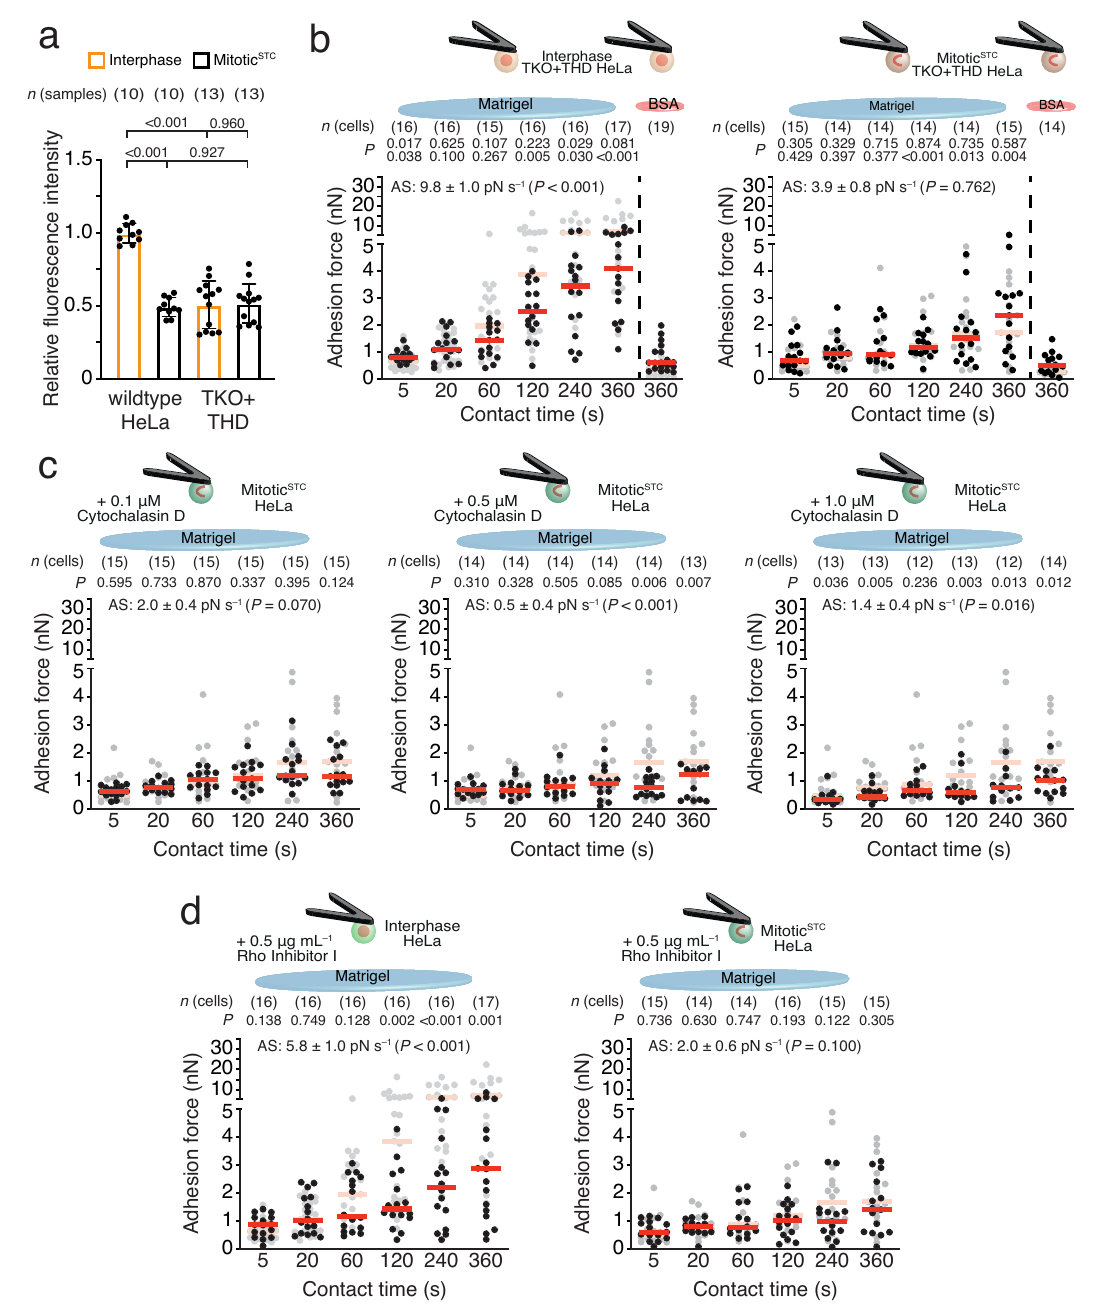
Fig. 6 | Mitotic cells do not engage integrins to the contractile actomyosin. a Fluorescence intensity of wildtype (Fig. 2b) or talin1-head domain expressing (TKO+THD) HeLa cells labeled for extended β 1 integrins (clone 9EG7). Dots represent median fl uorescence intensities of 20,000 cells normalized to the mean median fl uorescenceintensityofuntreatedinterphaseHeLacells,barsthemeanof allnormalizedmedians,and errorbarstheirSEM. n (samples)indicatesthenumber of biological independent samplestested. b Adhesionforcesofinterphase(left) or mitotic STC (right)TKO+THDHeLacellstoMatrigelorBSAaftergivencontacttimes. Dotsrepresentadhesionforcesofsinglecells,redbarstheirmedianand n (cells)the number of independent cells in at least three independent experiments. AS-values give the adhesion strengthening rate as the slope (±SE) of a linear fi t through adhesionforcesforallcontacttimeswiththe P valuecomparingtheAS-valuetothe